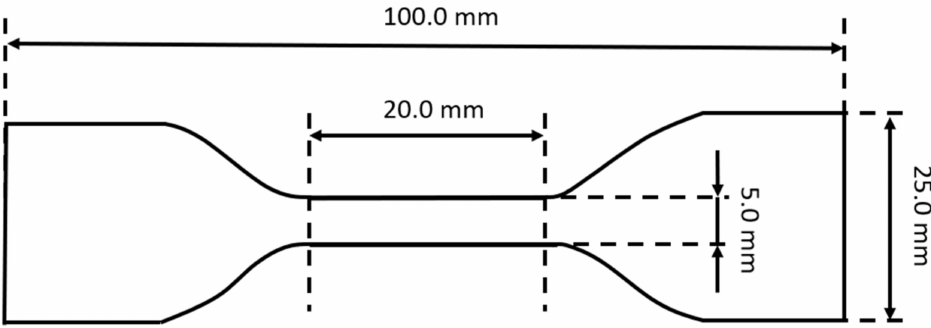
Figure 4. Schematic representation of dumbbell-shaped specimens with